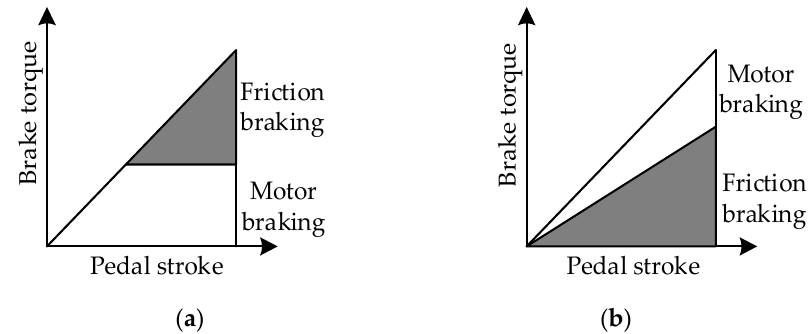
Figure 1. Cooperative braking control strategy: ( a ) parallel type; ( b ) series type .